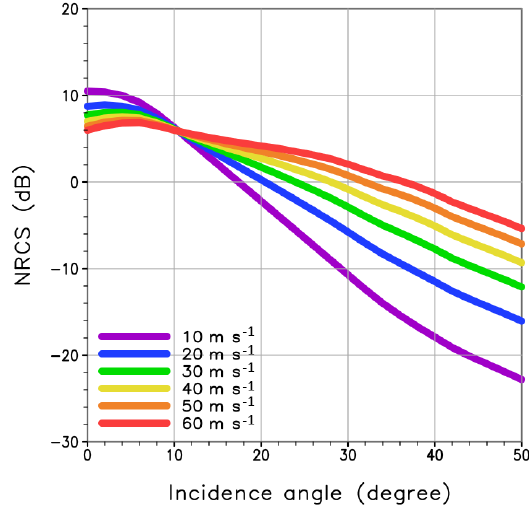
Figure 2. Normalized radar cross section (dB) as a function of inci- dence angle for six cases of 10m wind